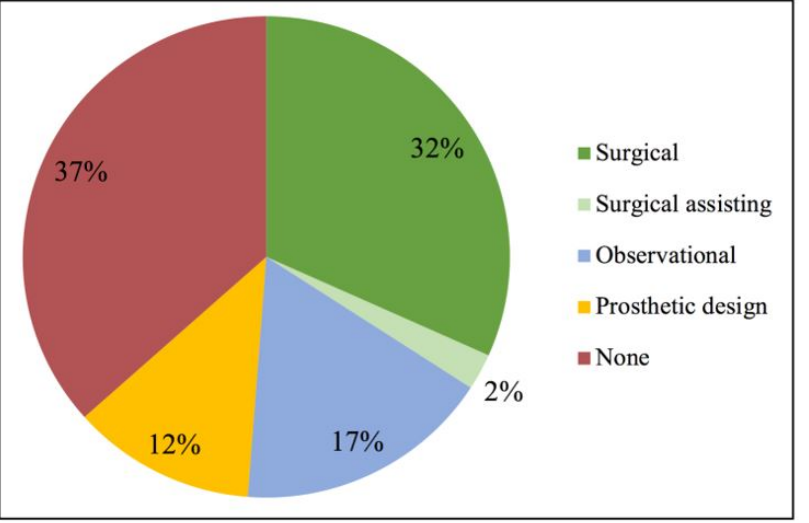
Figure 1. Participants’ level of experience with the use of personalized CAD/CAM scaffolds for horizontal and/or vertical bone augmentation.